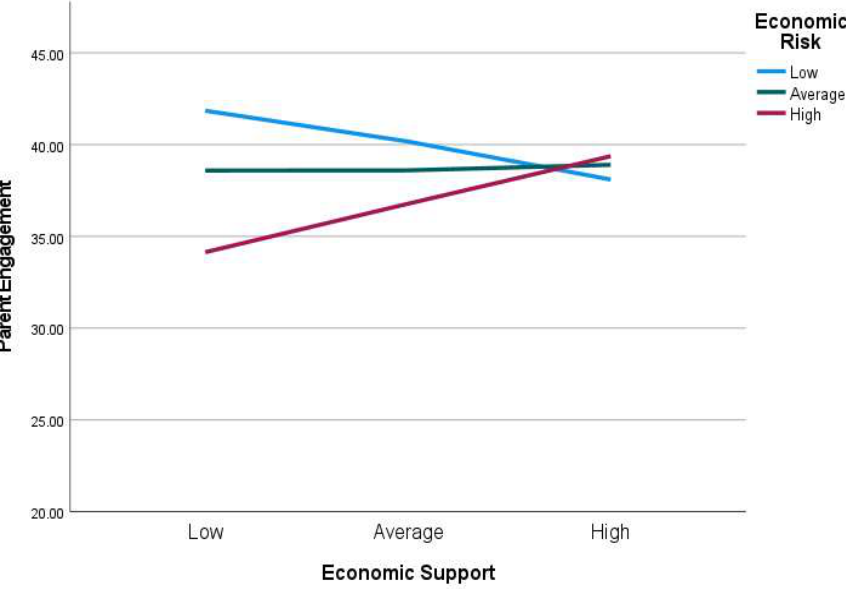
Figure 4. Economic support moderating the effect of economic risk on parental engagement scores. High = 1 standard deviation above the sample mean, average = sample mean, and low = 1 standard deviation below the sample mean.